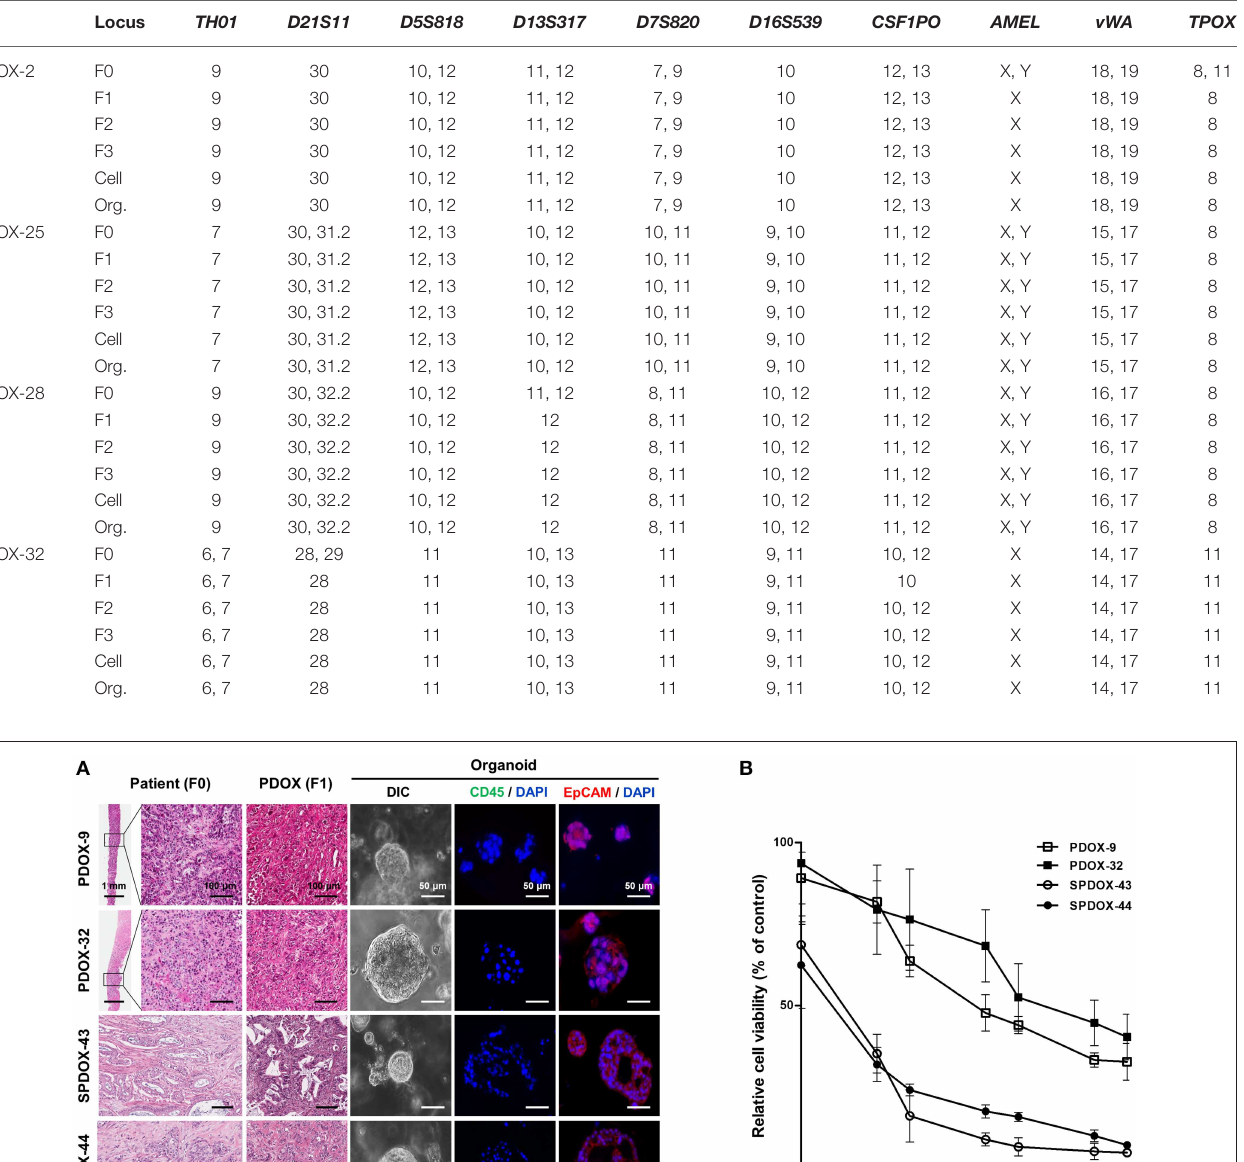
TABLE 3 | Short Tandem Repeat (STR) profiling of PDOX and organoid. Locus